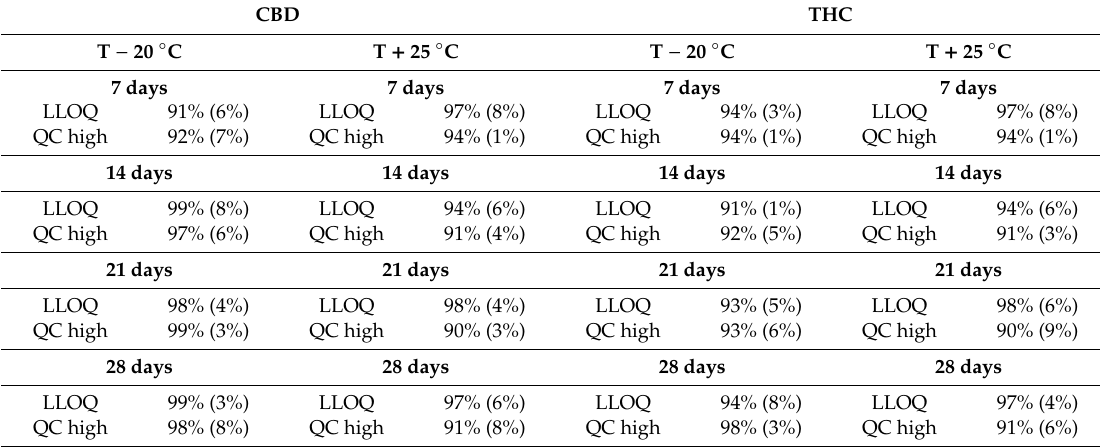
Table 2. Stability of CBD and THC measured on VAMS. Results are expressed as accuracy and CV